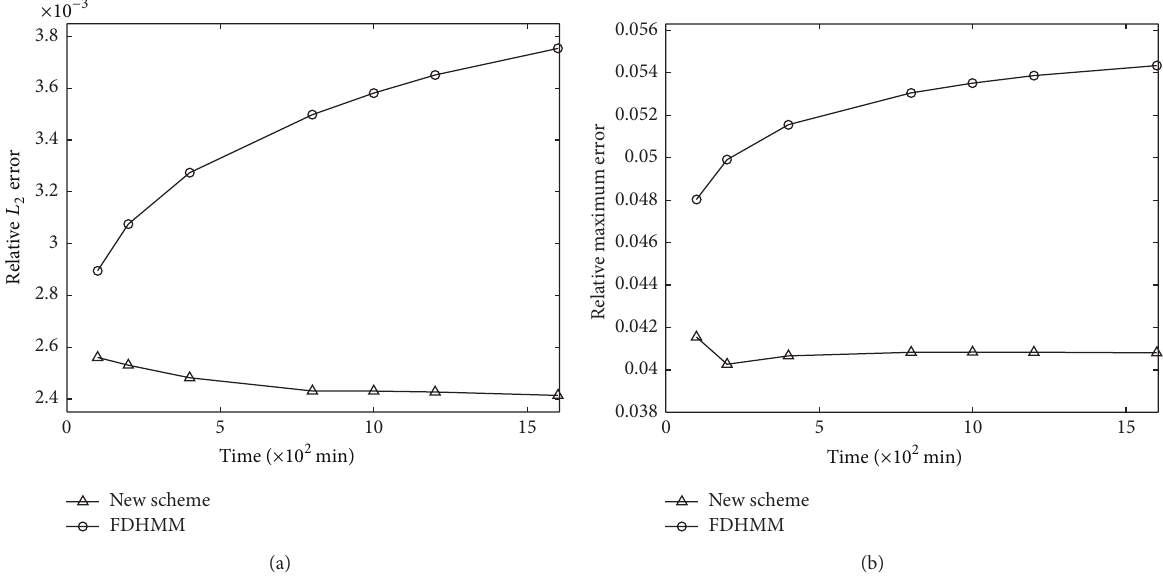
Figure 15: Relative (a) 𝐿 2 and (b) maximum errors between exact and two coarse solutions for the transient flow problem with weak well drawdown.